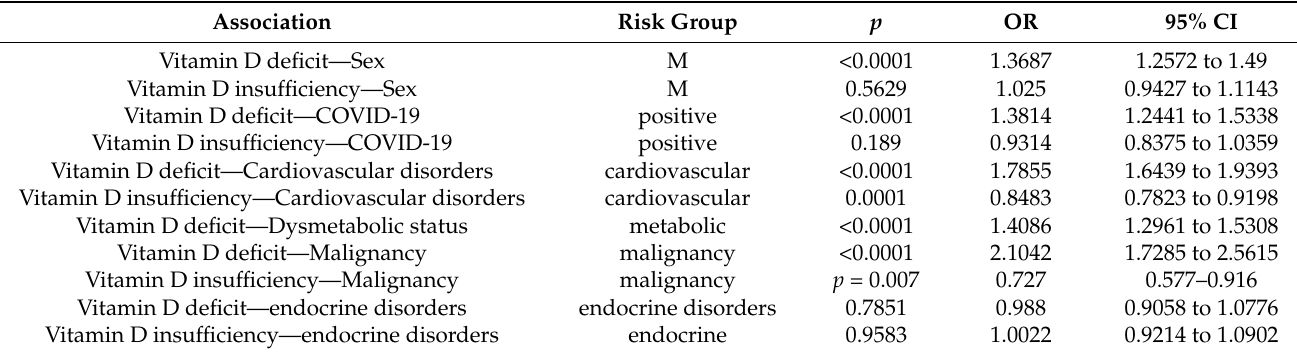
Table 5. Group risk and association with vitamin D